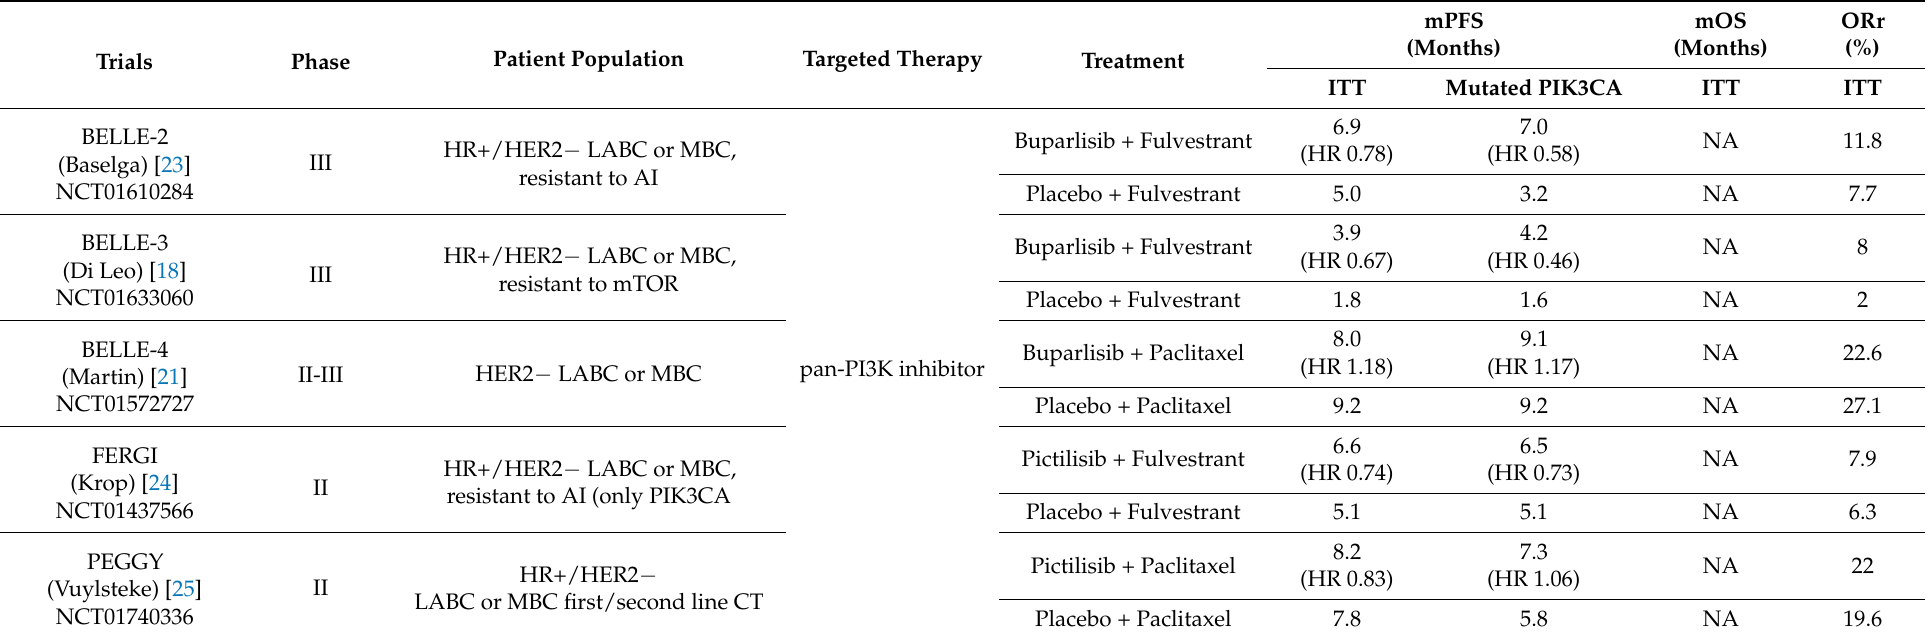
Table 1. Summary of phases II-III trials with PI3K-inhibitors in HR-positive/HER2-negative metastatic breast